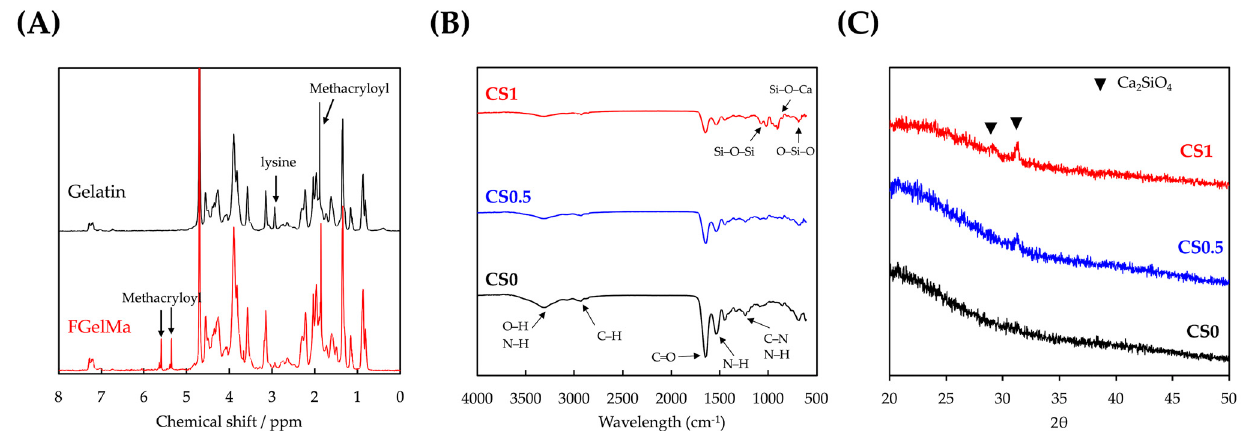
Figure 2. ( A ) The 1 H NMR spectra of gelatin and FGelMa; ( B ) FTIR; and ( C ) XRD for CS0, CS0.5, and CS1.